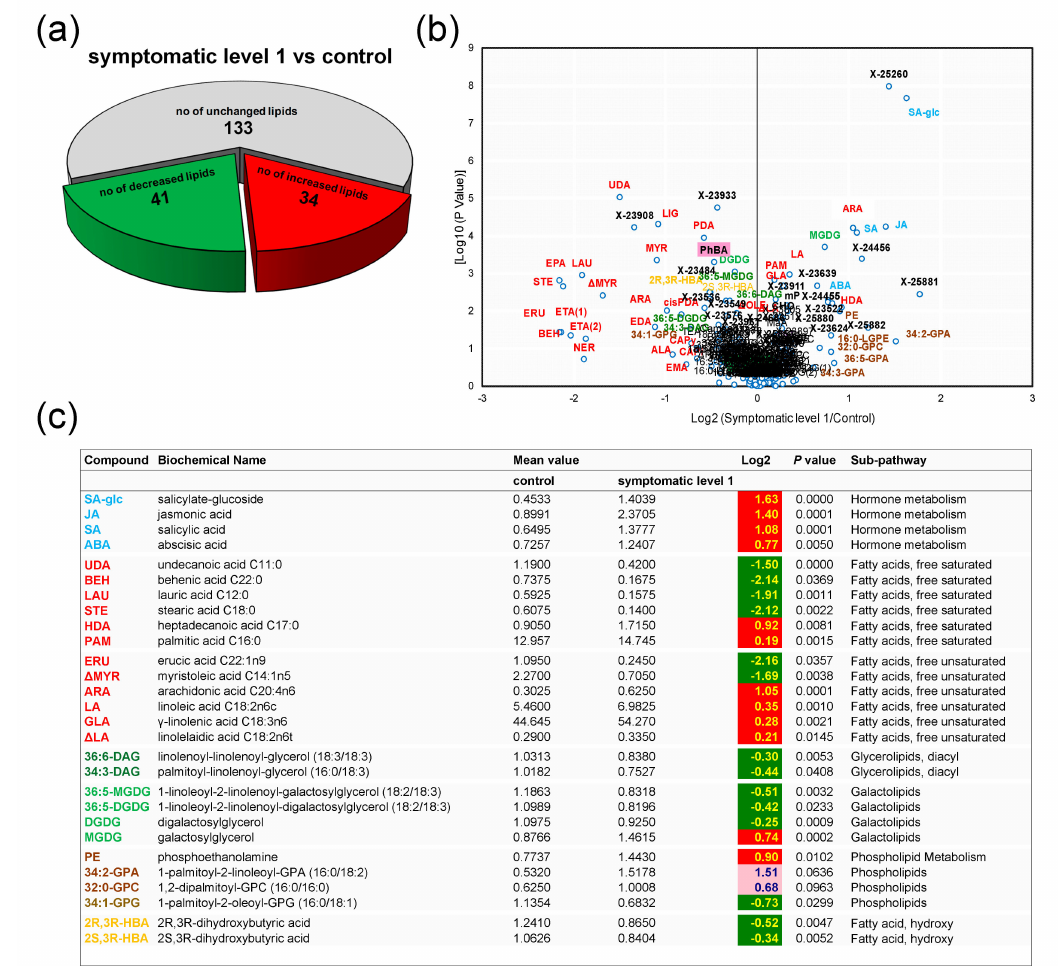
Figure 3. Variations in levels of hormones, lipid species, and other compounds of the metabolism of lipids in Vitis vinifera L. ‘Malvasia fina’ a ff ected by Esca complex disease (ESCA): ( a ) Pie plot representing the numbers of altered species in chlorotic leaves from foliar-symptomatic and wood-symptomatic vines (SY1) relative to healthy leaves from healthy una ff ected control vines (CTL). Levels were considered altered when they underwent a p -value ≤ 0.10 (Welch’s two-sample t -test, n = 6). ( b ) Volcano plot (log2 (SY1 / CTL) vs. [log10 ( p -value)]) illustration of species di ff erently accumulated in CTL and SY1. Abbreviations are as listed in Figure 3c and Table S1. ( c ) Representative compounds listed along a color gradient according to sub-pathways. Additional altered compounds can be found in Table S1. For log2 values, di ff erent colors represent di ff erent directions of change at p ≤ 0.05 (dark green = negative change; red = positive change) and at p ≤ 0.10 (light green = negative change; rose = positive